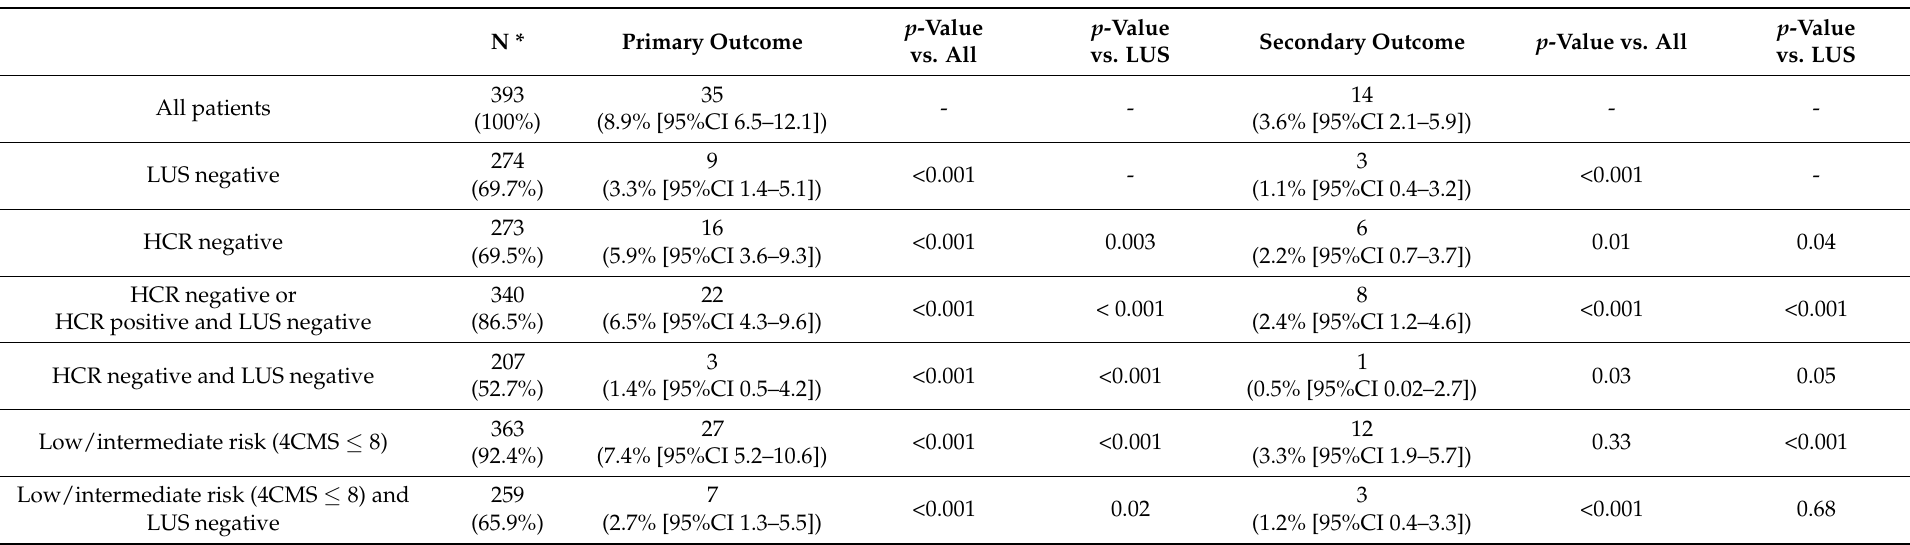
Table 2. Occurrence of primary and secondary outcomes in patient categories based on subjective evaluation alone (all patients), LUS, HOME-CoV (HCR), 4CMS or integration of LUS with HCR or